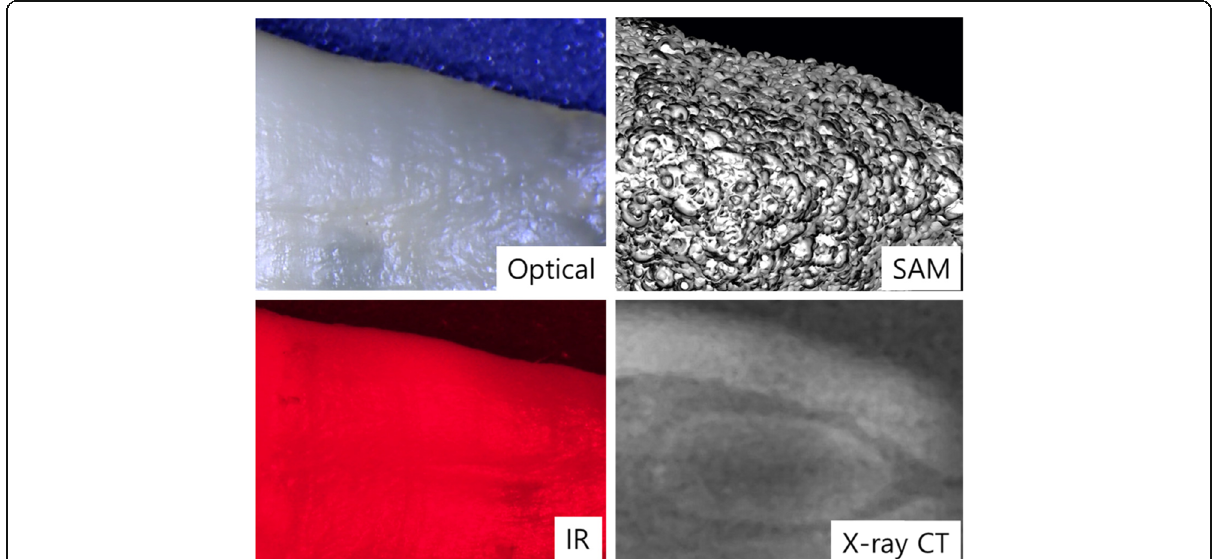
Fig. 2 Comparison of the analysis of the interior of the tooth using different imaging